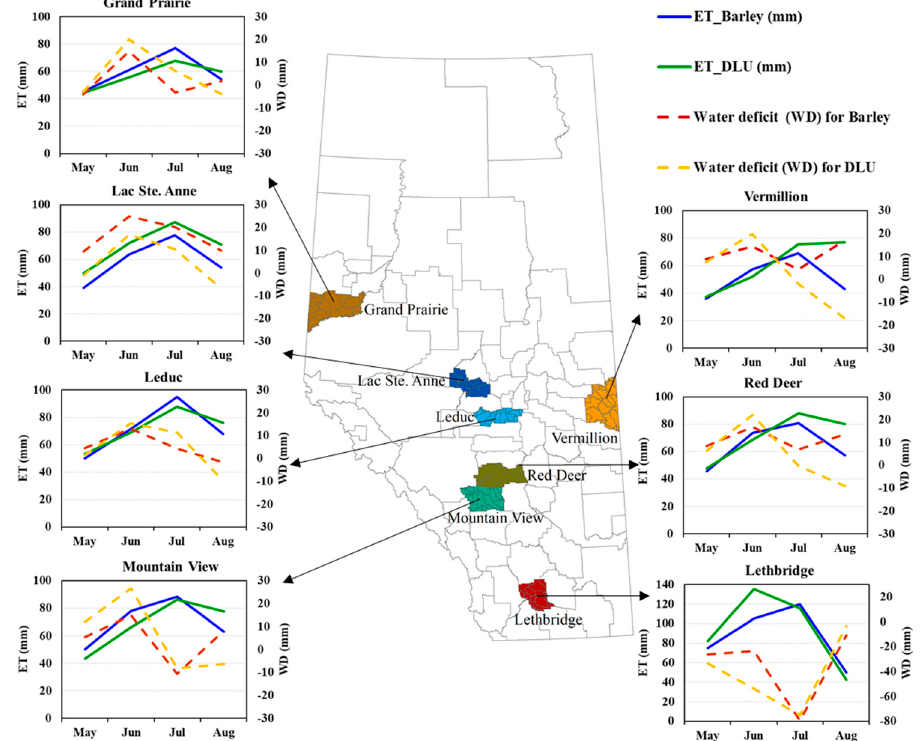
Figure 8. Comparison of evapotranspiration (ET) for dominant land use (DLU) and barley in seven selected counties for the historical 1983–2007 period. Water deficit (WD), which is calculated as the difference in between precipitation and ET for DLU, is also shown in the secondary y-axis.